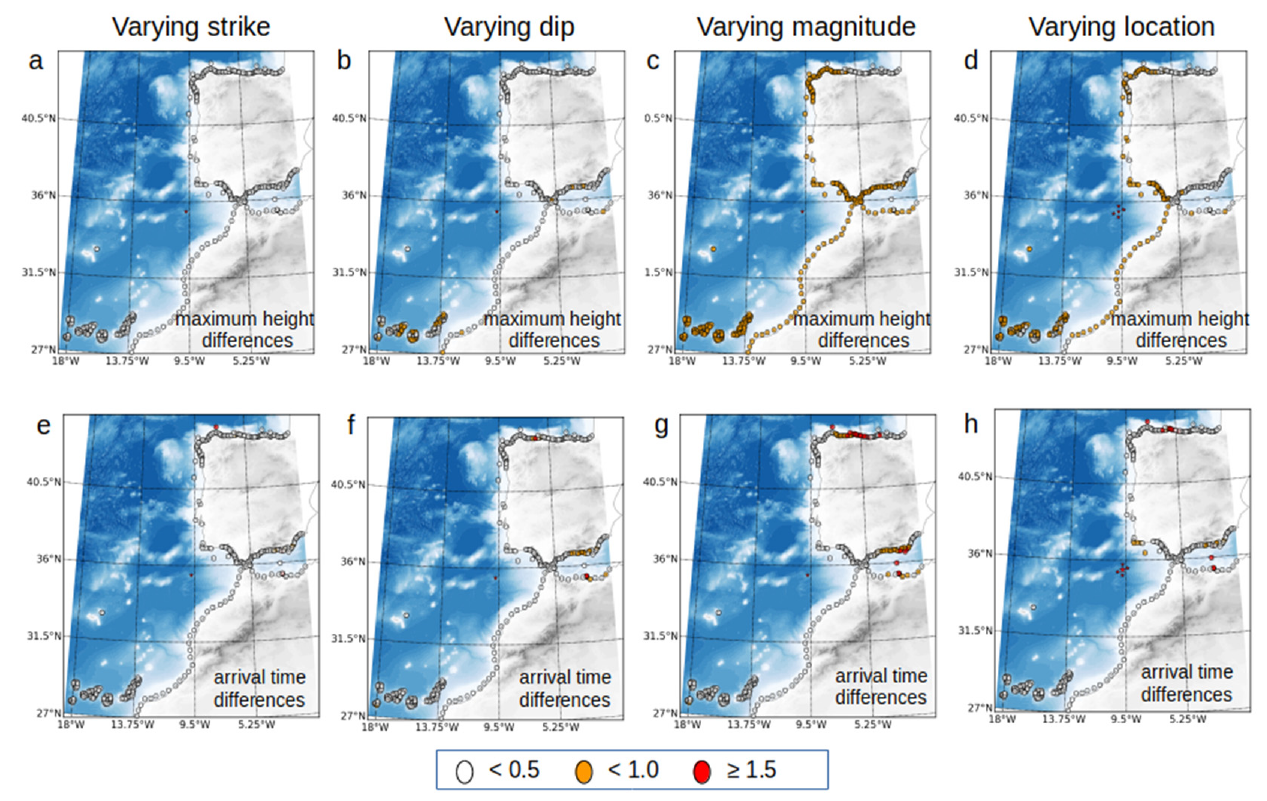
Figure 6. Geographic distribution of normalized largest differences in maximum height and arrival time for the same cases as in Figure 5, varying one source parameter from the reference scenario. ( a , e ) Differences between cases in which the strike is varied; ( b , f ) the dip is varied; ( c , g ) the magnitude is varied; ( d , h ) the location is varied. The differences are normalized with respect to the values of the reference scenario. The color of the circles indicates the ratio between the largest differences for each case and the values of the reference scenario in each